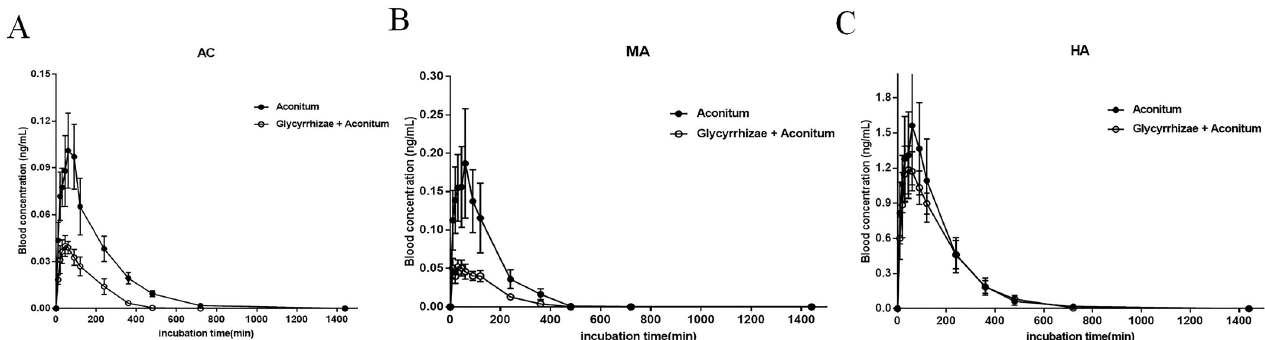
Fig 6. The effects of Aconitum and the compatibility of Glycyrrhizae and Aconitum on the plasma concentrations of AC, MA and HA in rats. Aconitum and the compatibility of Glycyrrhizae and Aconitum 2 mL / kg were given by gavage respectively. At 10, 20, 30, 45, 60, 90, 120, 240, 360, 480, 720 and 1440 min after administration, 0.3 mL of blood was taken from the ophthalmic venous plexus, separated plasma and analyzed by LC-MS / MS. The plasma concentrations of AC (A), MA (B) and HA (C) in rats with compatibility of Glycyrrhizae and Aconitum were significantly lower than those with Aconitum